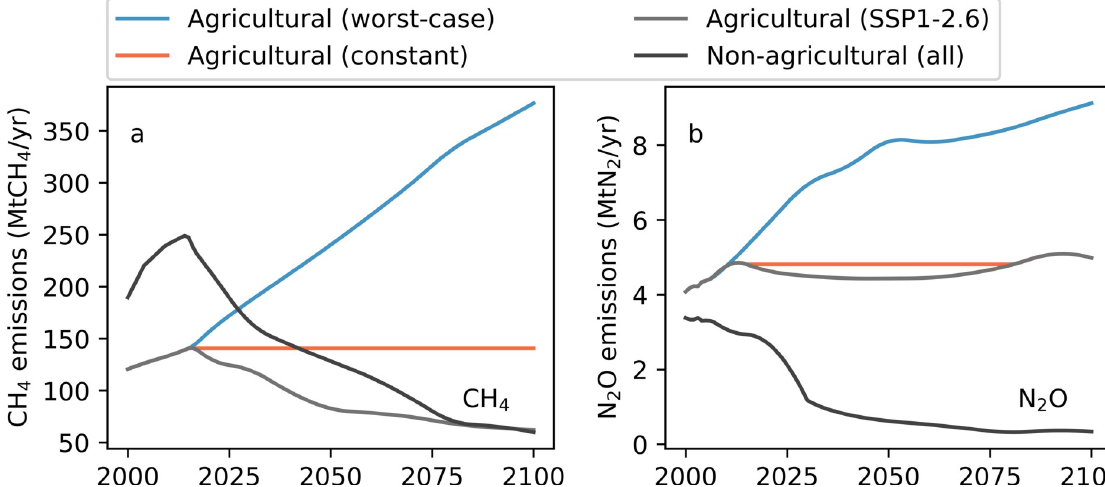
Fig 1. Methane (panel a, “CH 4 ”) and nitrous oxide (panel b, “N 2 O”) emission pathways under the SSP1-2.6 and alternative scenarios (constant and worst-case emissions). Agricultural emissions differ between the three scenarios (SSP1-2.6, constant, and worst-case) while non-agricultural emissions are the same in all three scenarios (and corresponding to SSP1-2.6 emissions). The data used to reproduce this figure are publicly available in the IIASA SSP database [60–63].